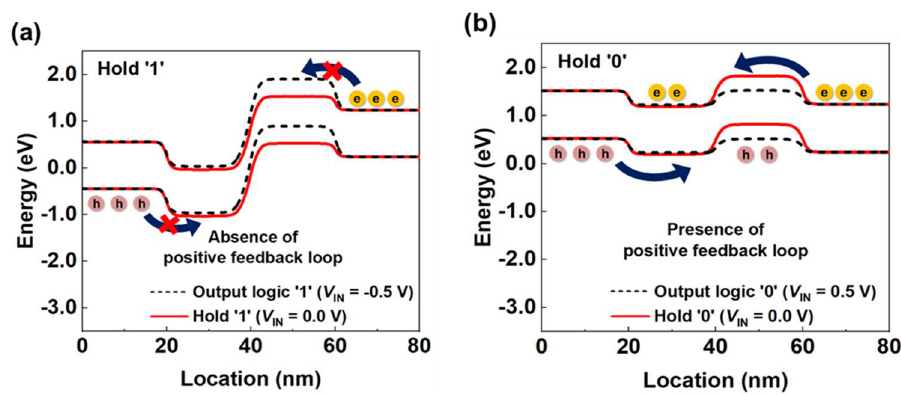
Figure 4. ( a ) Energy band diagrams of n-FBFET in the ( a ) output logic ‘1’ and hold ‘1’ and ( b ) output logic ‘0’ and hold ‘0’.